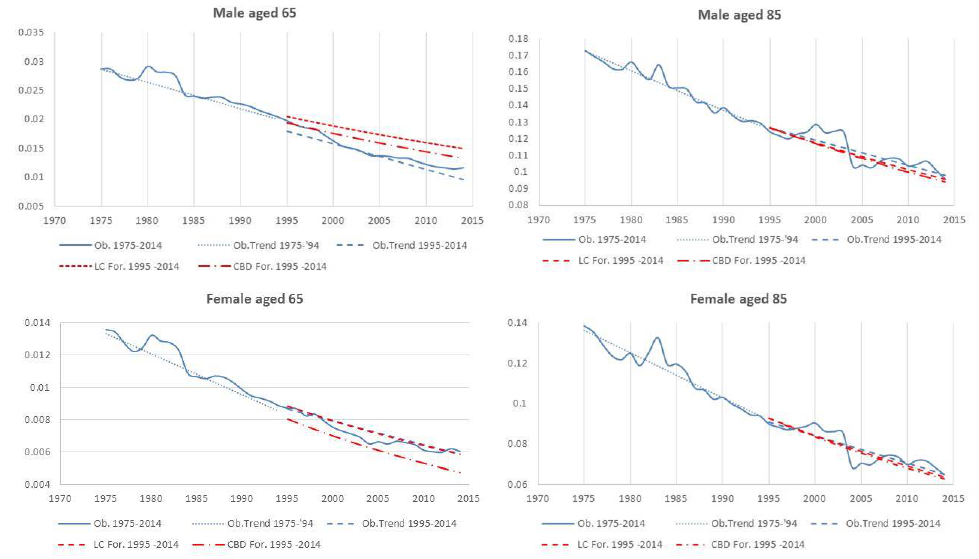
Figure 5. LC and CBD models: comparisons between observed and forecast mortality trends.